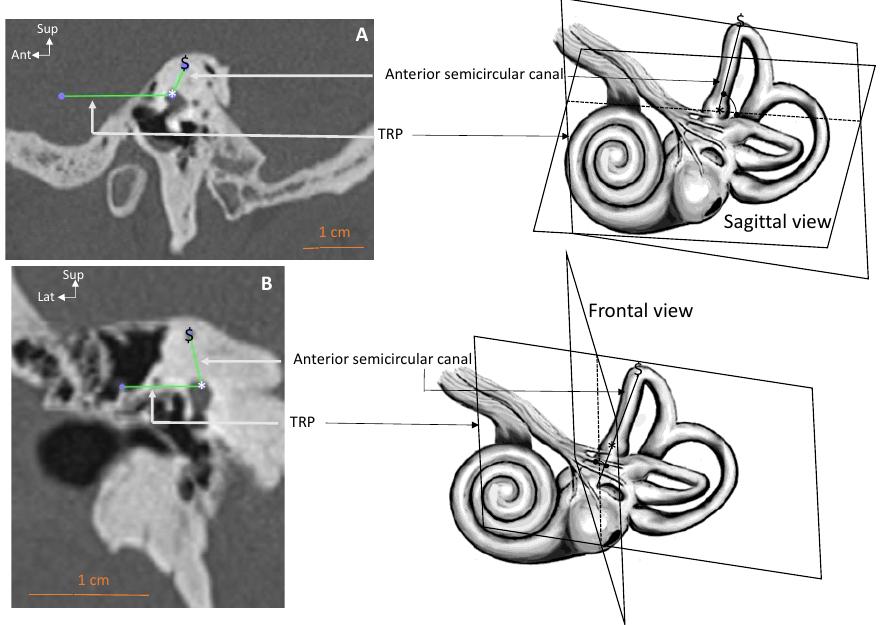
Figure 3. Angle measurements for the anterior semicircular canal (SCC) in the sagittal ( A ) and the